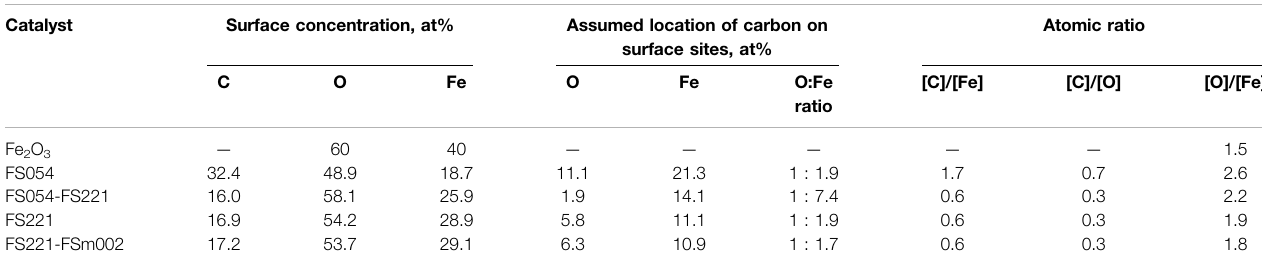
TABLE 2 | Elemental surface composition of catalysts from the XPS analysis.